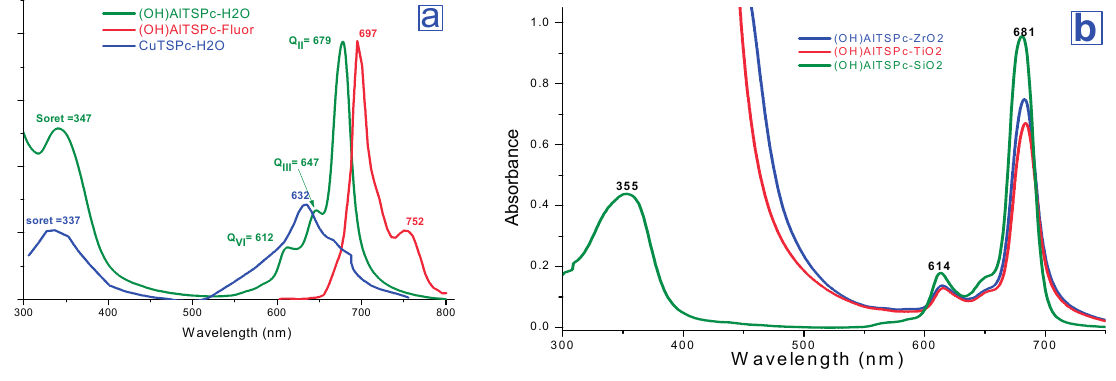
Figure 2. ( a ) UV-Vis spectra of monomeric (OH)AlTSPc species and CuTSPc aggregates of both in aqueous solution; and ( b ) UV-Vis spectra of (OH)AlTSPc species physically trapped inside ZrO 2 and TiO 2 pore